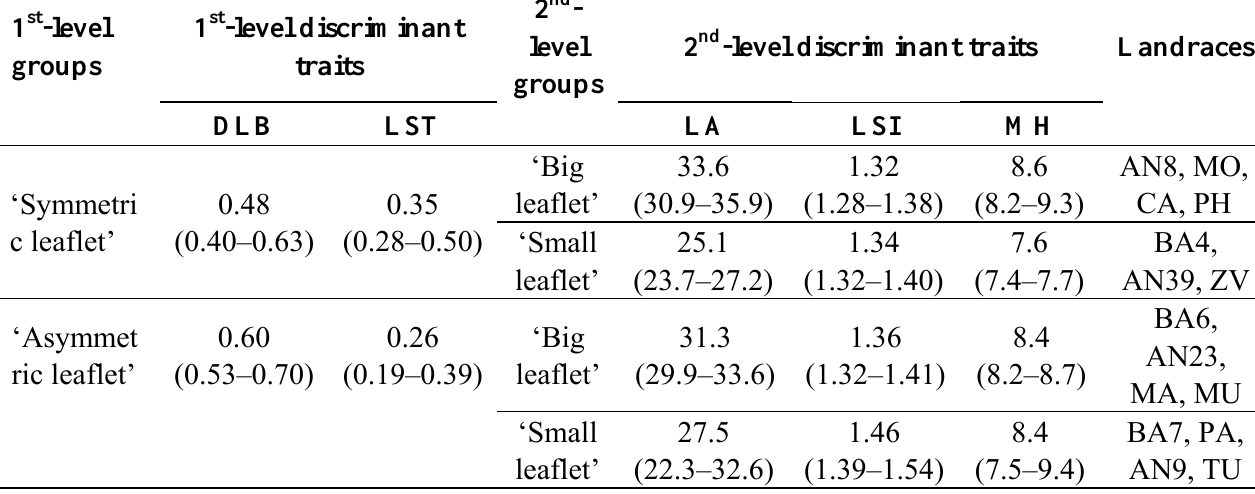
Table 3. Group mean value and range of individual means (in parenthesis) for the leaflet morphometric traits discriminating the landraces into four